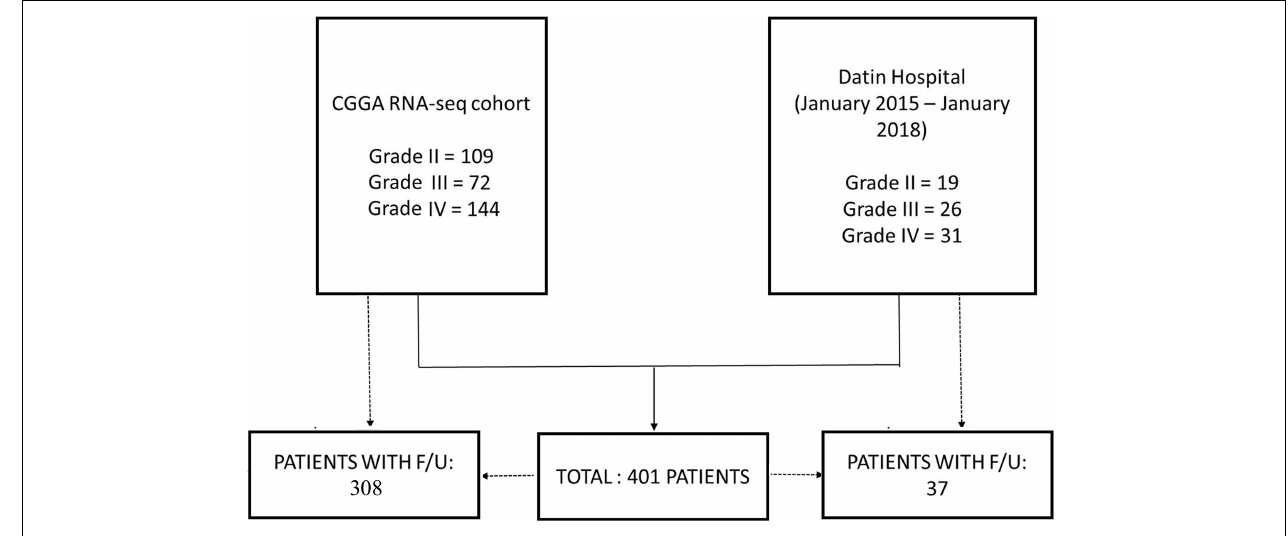
FIGURE 1 | CONSORT-like diagram of patients enrolled in the